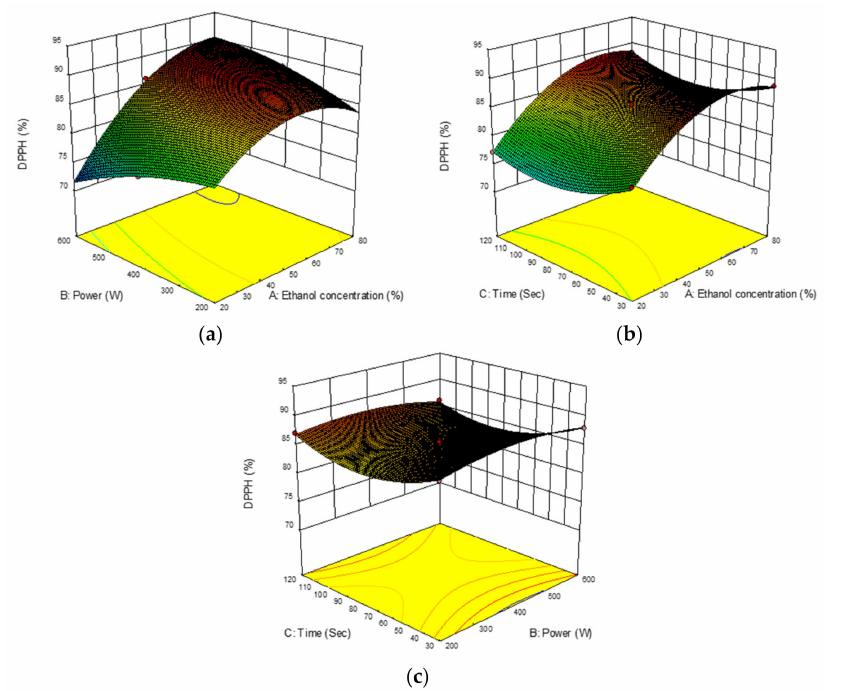
Figure 4. Response surface analysis (3D) of Barleria lupulina Lindl. leaf extract (BLLE) on DPPH activity: ( a ) effect of ethanol concentrations and microwave power; ( b ) effect of ethanol concentrations and extraction time; ( c ) effect of microwave power and extraction